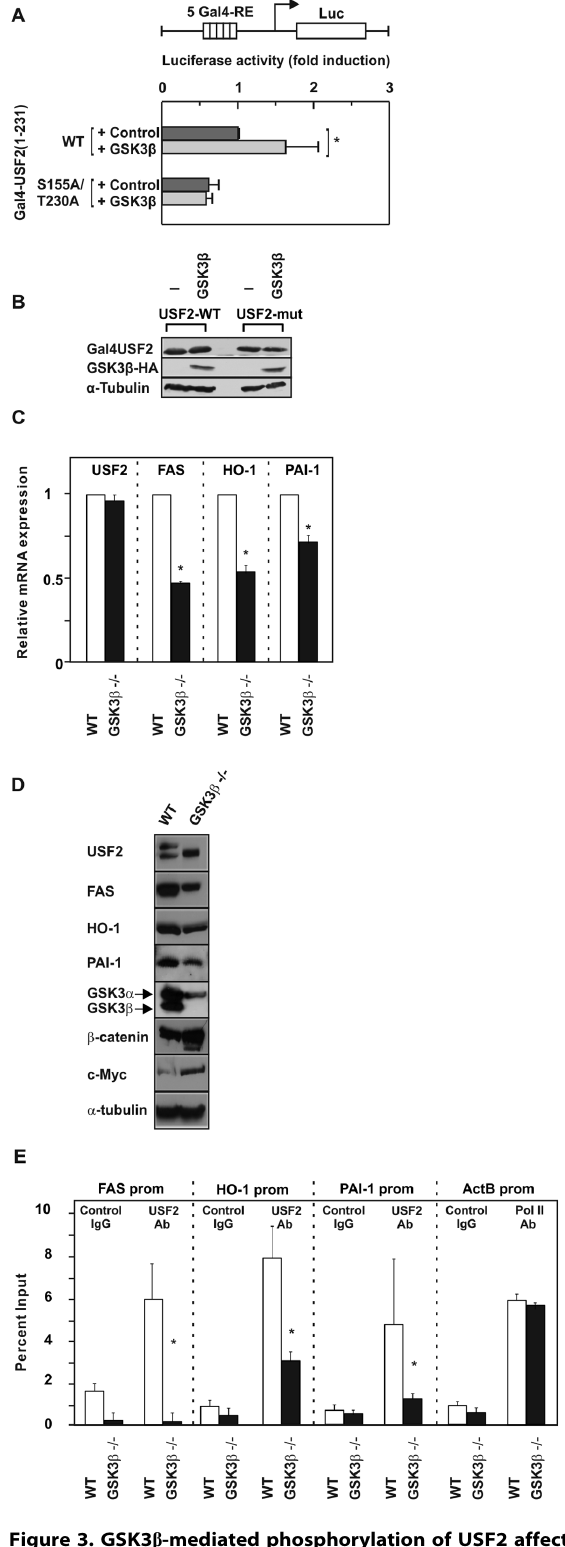
Figure 3. GSK3 b -mediated phosphorylation of USF2 affects its transactivity, DNA binding and target gene expression. (A) HeLa cells were cotransfected with pFR-5Gal4-RE-Luc, an expression vector for constitutively active GSK3 b -S9A and WT or mutant pcDNA6-Gal4- USF2 (1-231) or the appropriate empty Gal4 vector. The luciferase activity was calculated as fold induction compared to the Gal4-USF2